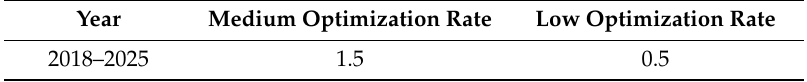
Table 6. Values set for conversion efficiency of thermal power in China from 2018 to 2025